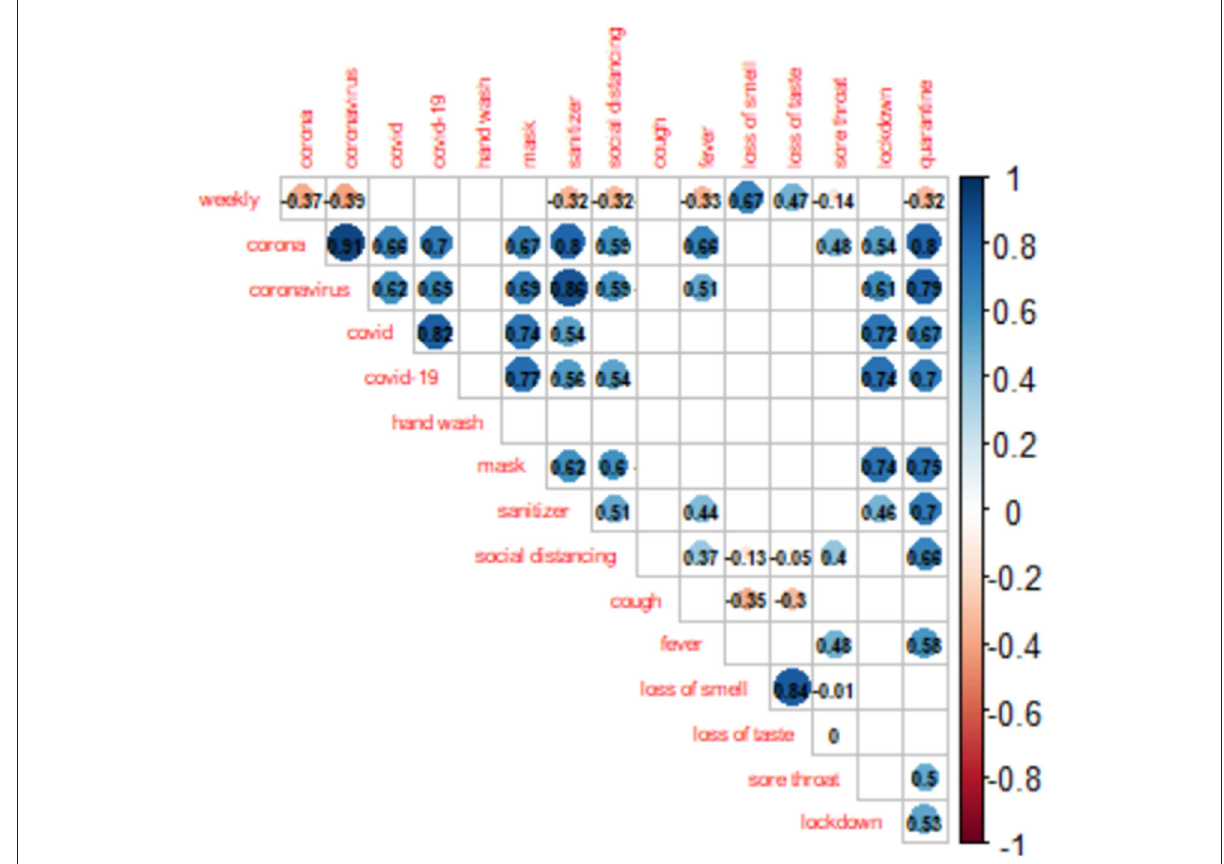
FIGURE2 Spearman correlations among GT data and the weekly COVID-19 cases in Nigeria. The blank spaces indicate insignificant correlations ( p <